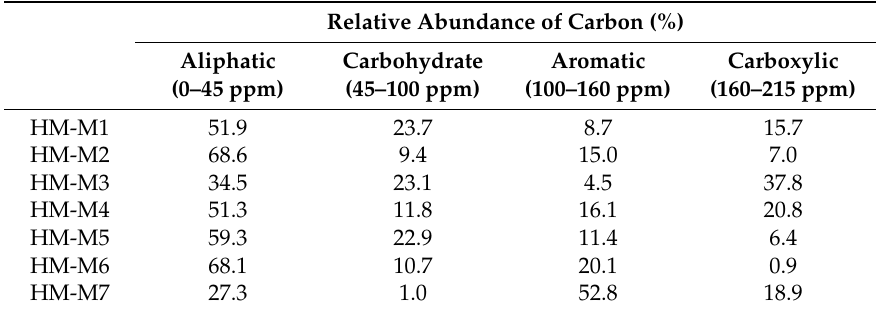
Figure 5. Solid-state 13 C CP/MAS nuclear magnetic resonance (NMR) spectra of the seven HMs. Table 3. Relative abundance of carbon in the seven HMs estimated from 13 C CP/MAS NMR